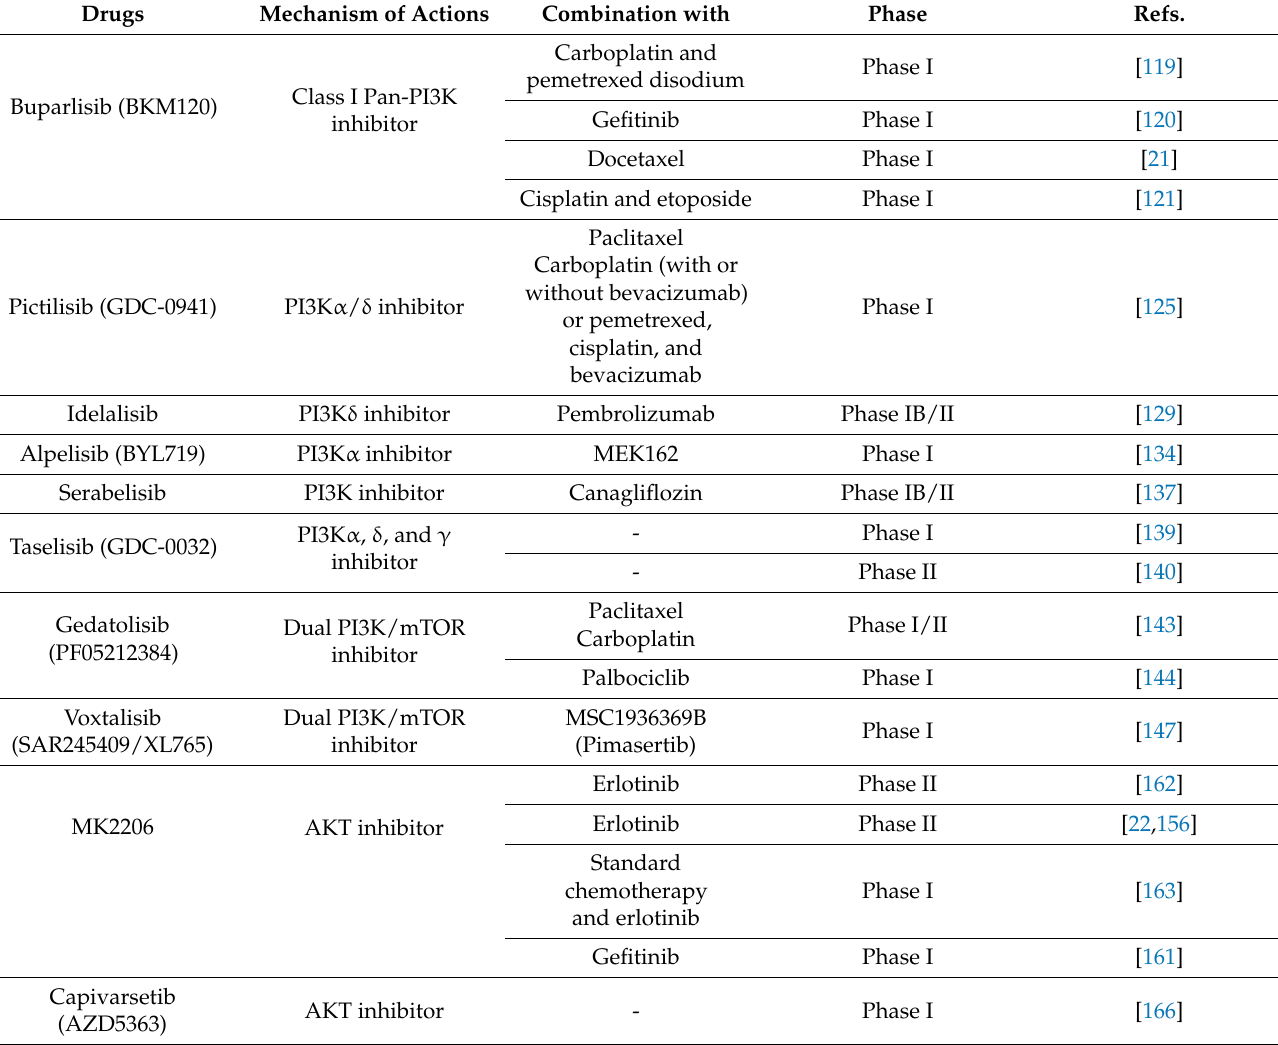
Table 1. Ongoing clinical trials of several drugs targeting PI3K/AKT/mTOR signaling in lung cancer. Drugs Mechanism of Actions Combination with Phase